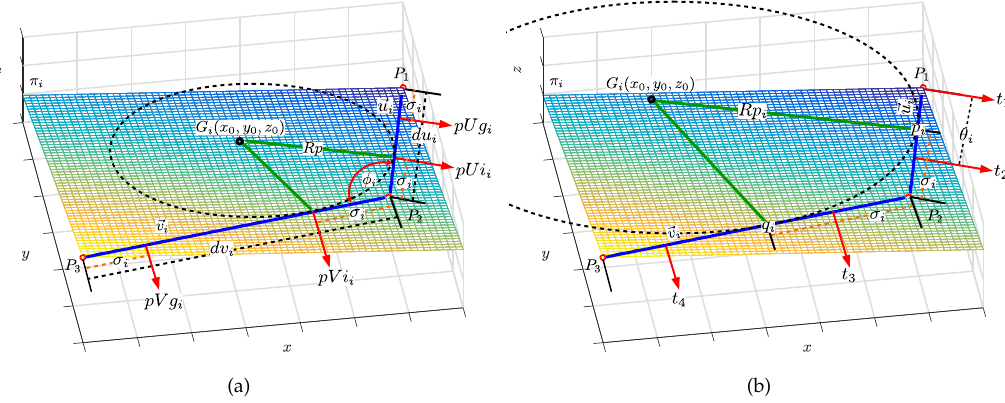
Figure 4. Description of the methodological basis. The circle of black dots shows the osculating sphere ( oS ) ; the green line is the radius of turn Rp i . ( a ) Sphere location G i with minimum turning radius. ( b ) Sphere location G i with upper turning radius displaced within the bounds given by [ t 1 , t 2 ] and defined by the value of θ i .